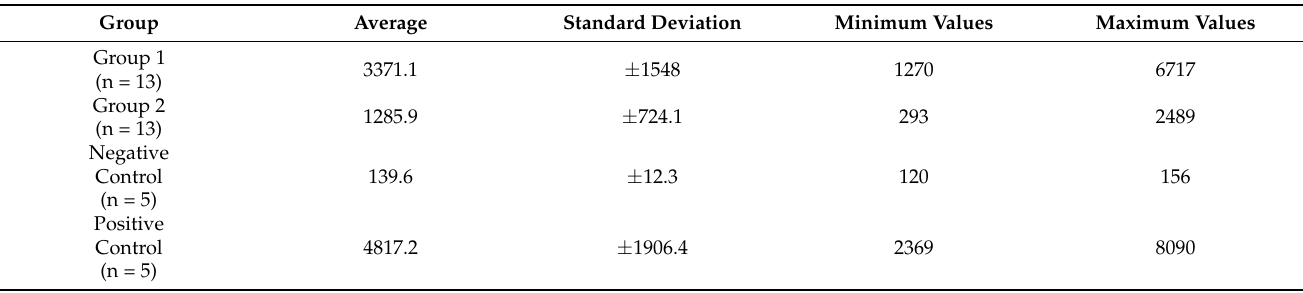
Figure 1. Visual representation of radioactivity emitted by the specimens detected by a gamma camera of one tooth per group (CPM—Counts Per Minute). Table 2. Statistical analysis of laboratory results. Values in CPM (counts per